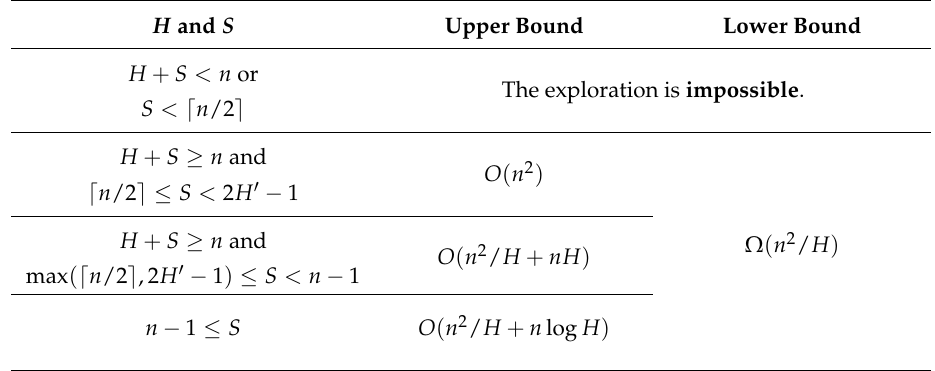
Table 1. Upper and lower bounds of the exploration time in 1-interval connected rings where H (cid:48) = min ( H , (cid:98) n /2 (cid:99) ) . H and S Upper Bound Lower Bound H + S < n or The exploration is impossible . S < (cid:100) n /2 (cid:101) H + S ≥ n and O ( n 2 ) (cid:100) n /2 (cid:101) ≤ S < 2 H (cid:48) − 1 Ω ( n 2 / H ) H + S ≥ n and O ( n 2 / H + nH ) max ( (cid:100) n /2 (cid:101) ,2 H (cid:48) − 1 ) ≤ S < n − 1 n − 1 ≤ S O ( n 2 / H + n log H